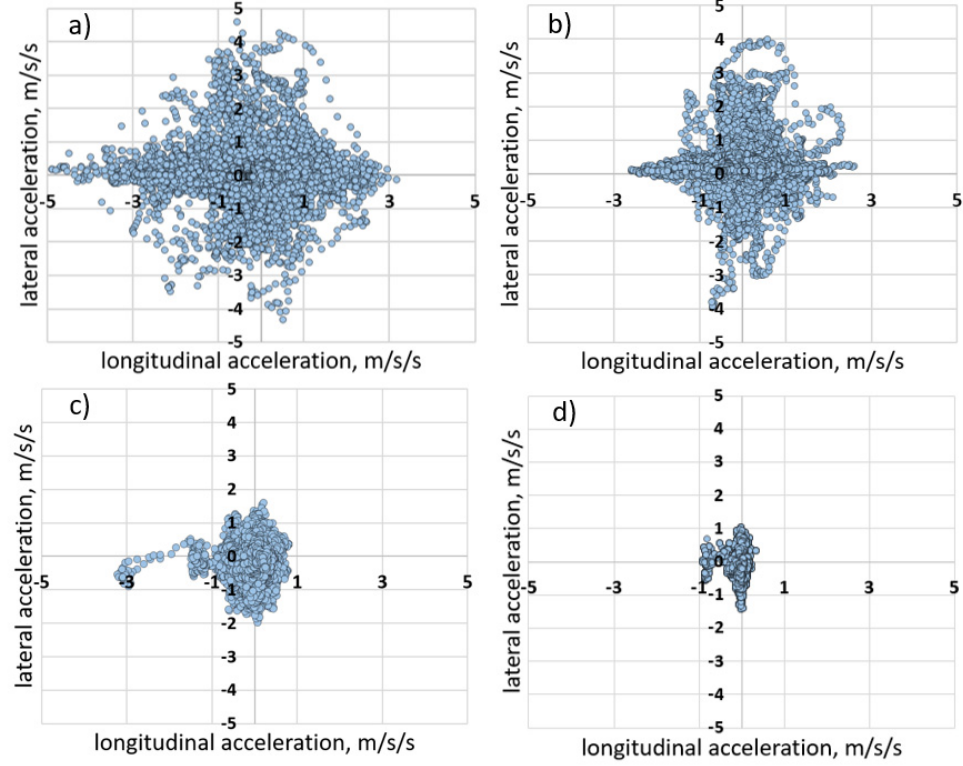
Figure 5. Comparison of the ranges of longitudinal and lateral acceleration values on various road types: ( a ) urban area (city); ( b ) non-urban area (single roadway with two traffic lanes); ( c ) two- roadway expressway; ( d ) motorway.